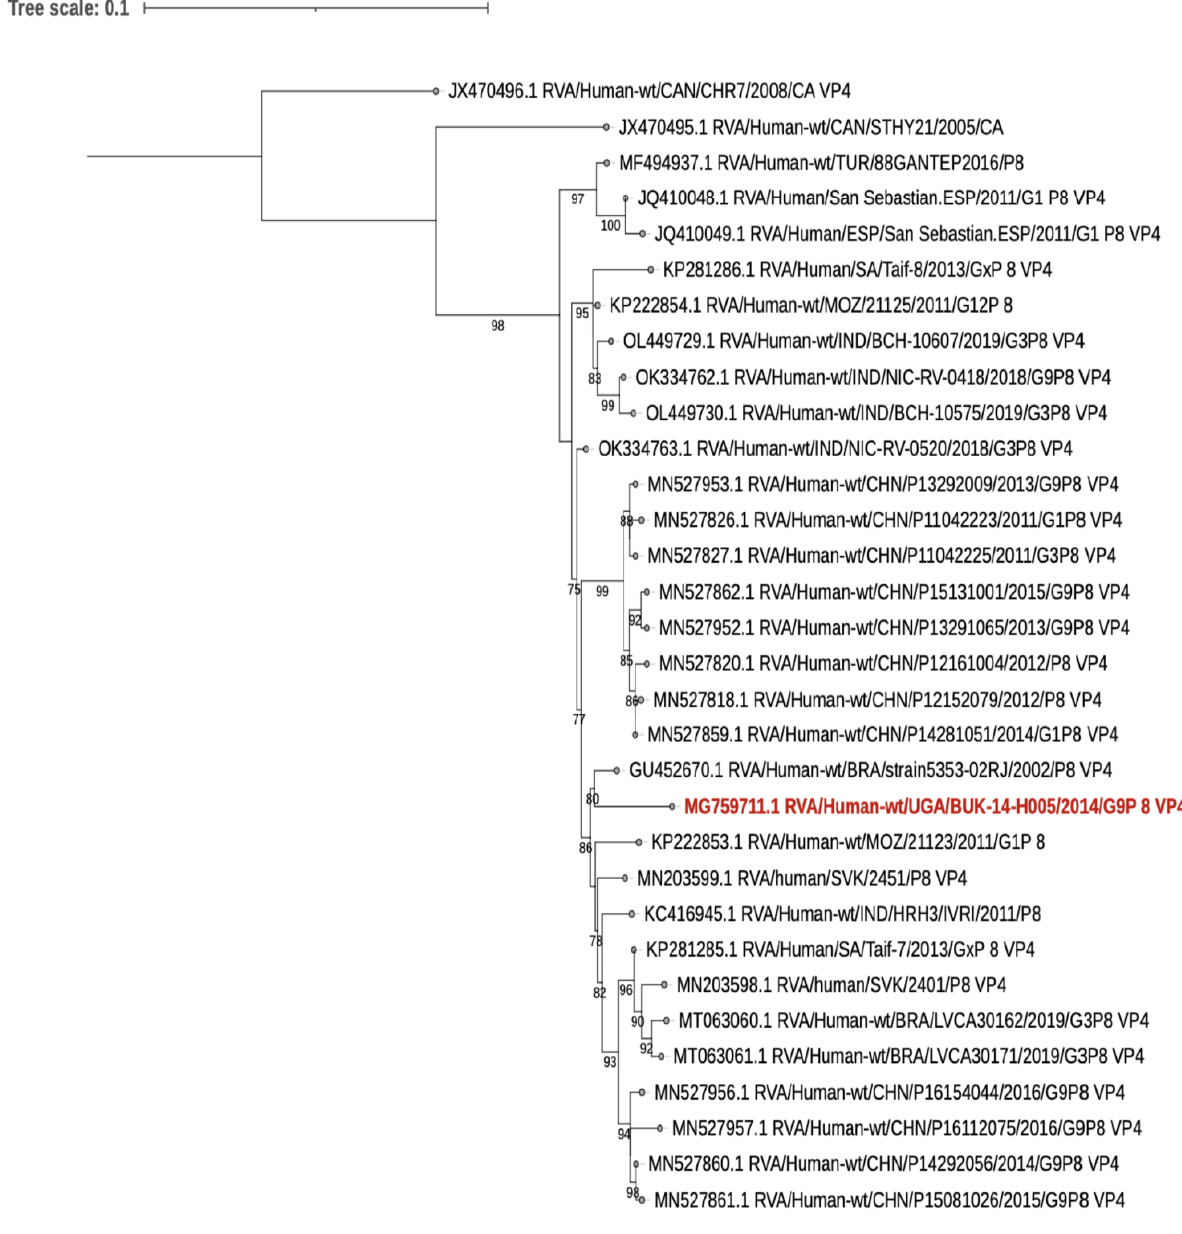
Figure 2. VP4. A Maximum-likelihood phylogenetic tree based on the Hasegawa–Kishono–Yano plus empirical base frequencies plus discrete gamma model generated using IQ-TREE (3) and run for 1000 pseudo replicates. Bootstrap values greater than 75% are shown at the nodes. The study human strain is in red.